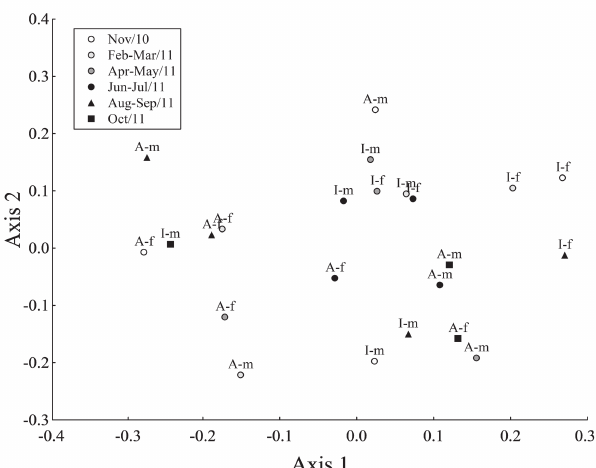
Fig. 2. Nonmetric multidimensional scaling (NMDS) applied to investigate variation in the diet of Cichla piquiti according to periods, sex (m = males; f = females) and maturity (I = immature; A = adult).